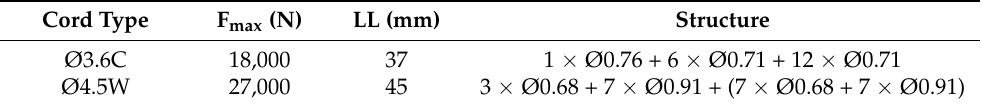
Table 3. Nominal maximum force, lay length and structure of steel